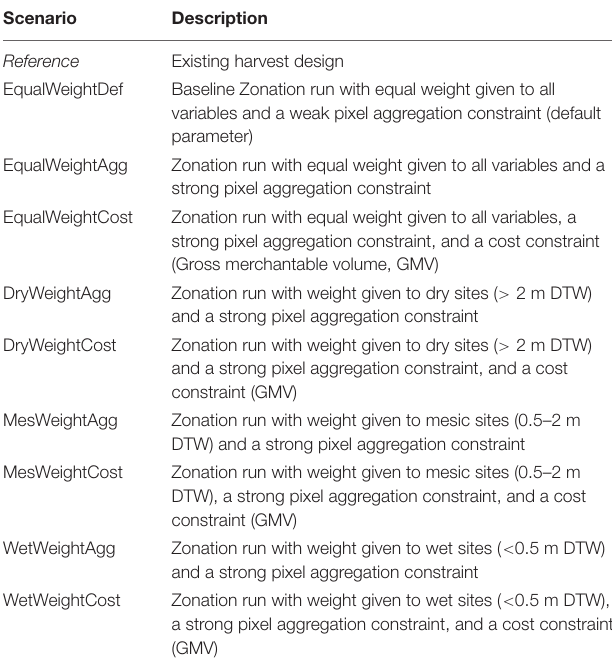
TABLE 4 | Details pertaining to the scenarios modeled using